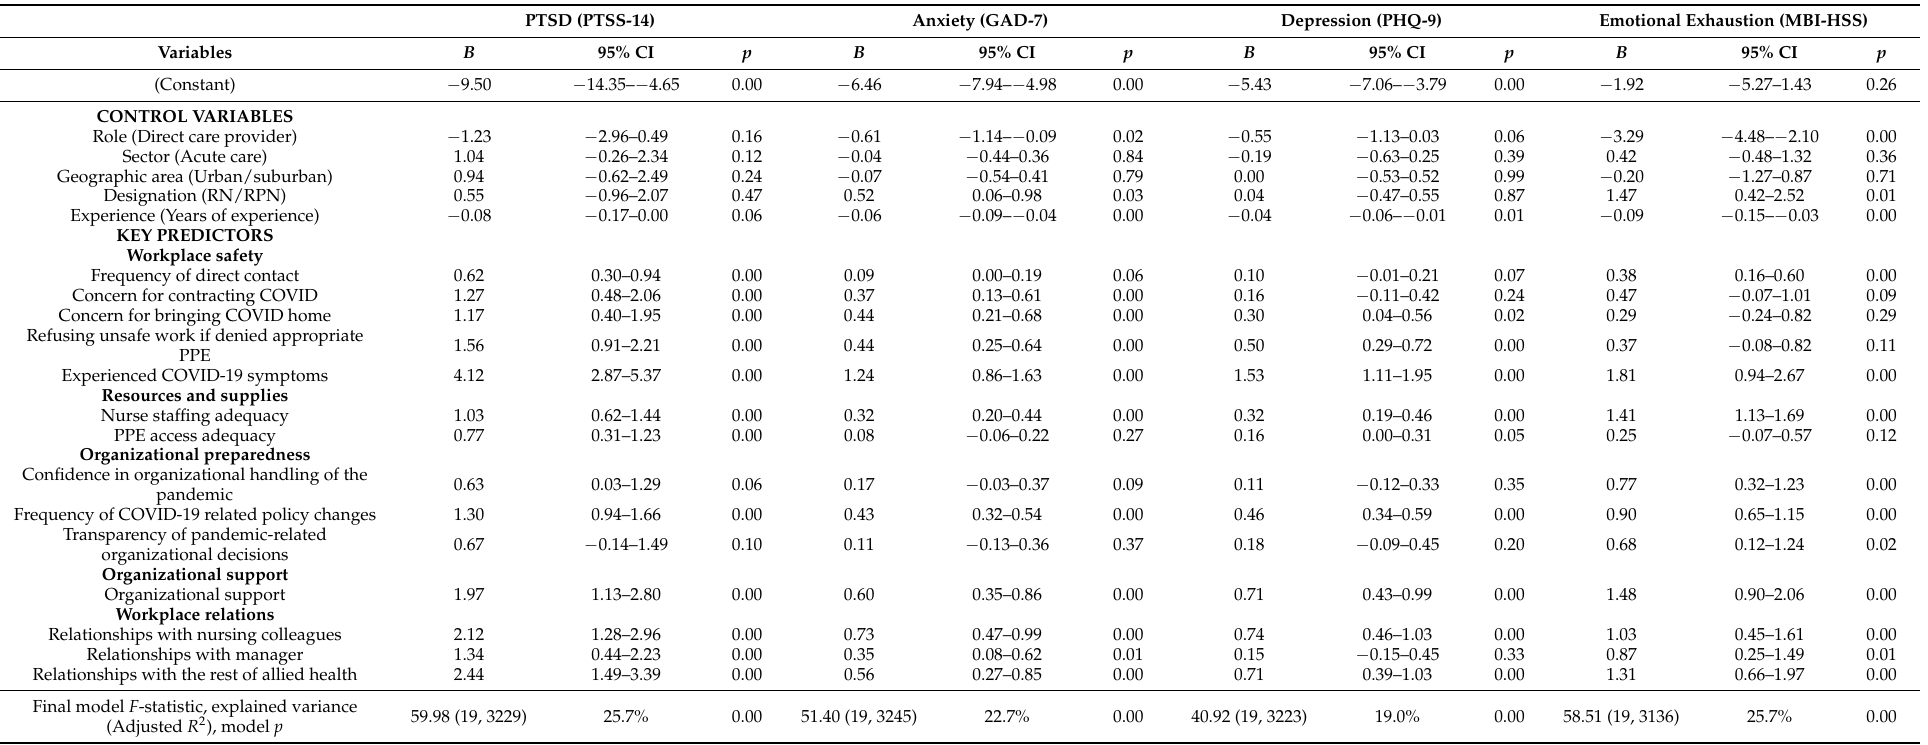
Table 4. Final linear regression models regressing PTSD, anxiety, depression, and EE measure sum scores on demographic control and workplace condition variables. PTSD (PTSS-14) Anxiety (GAD-7) Depression